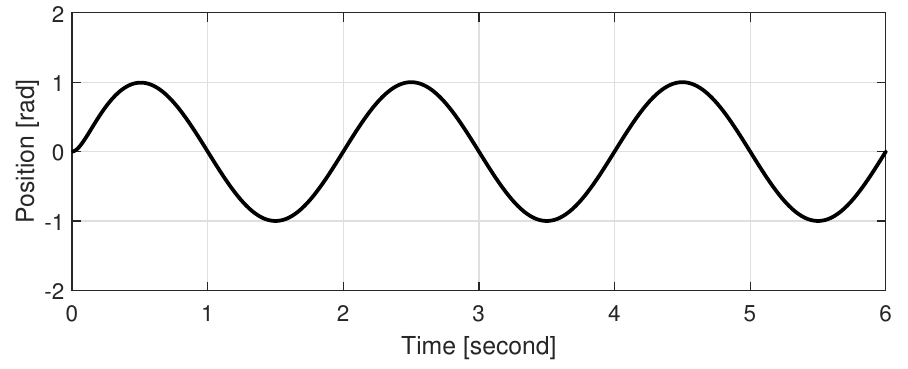
Figure 3. Desired